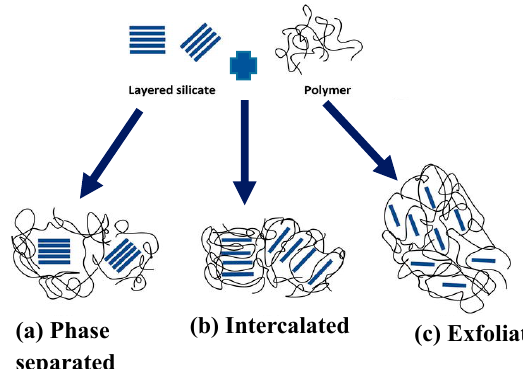
Figure 11. The main types of nanocomposites: ( a ) intercalated, ( b ) flocculated and ( c ) exfoliated. Reproduced with permission from Reference [113]. Open Access 2018, IntechOpen.